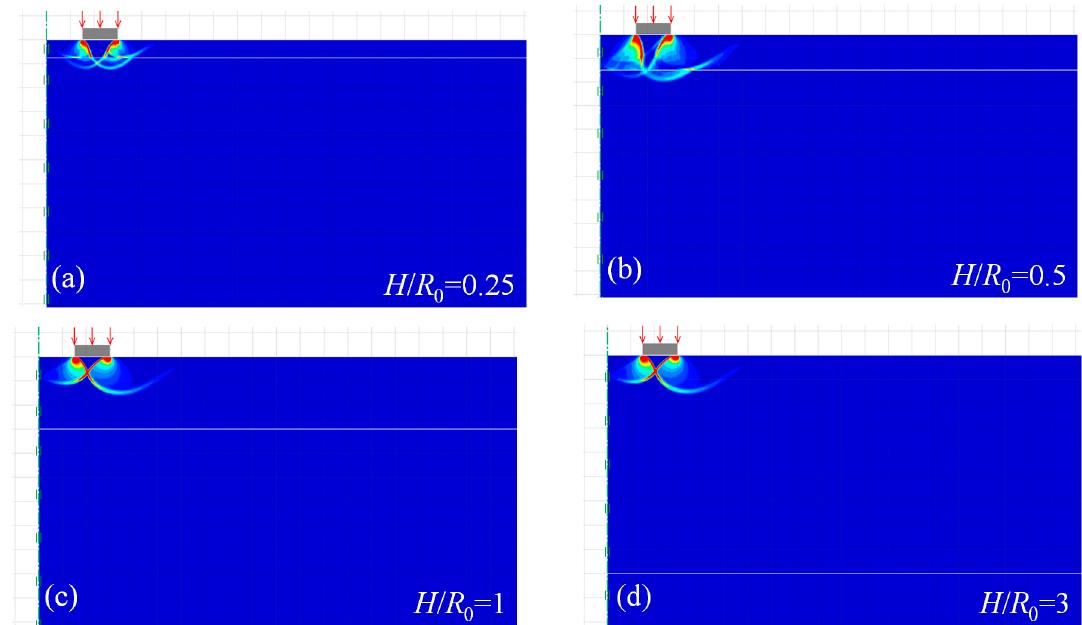
Figure 11. Upper bound collapse mechanisms for R i / R 0 = 0.5, φ =35°, c u /( γ R 0 ) = 2 with (a) H / R 0 = 0.25, (b) H / R 0 = 0.5, (c) H / R 0 = 1, and (d) H / R 0 = 3.